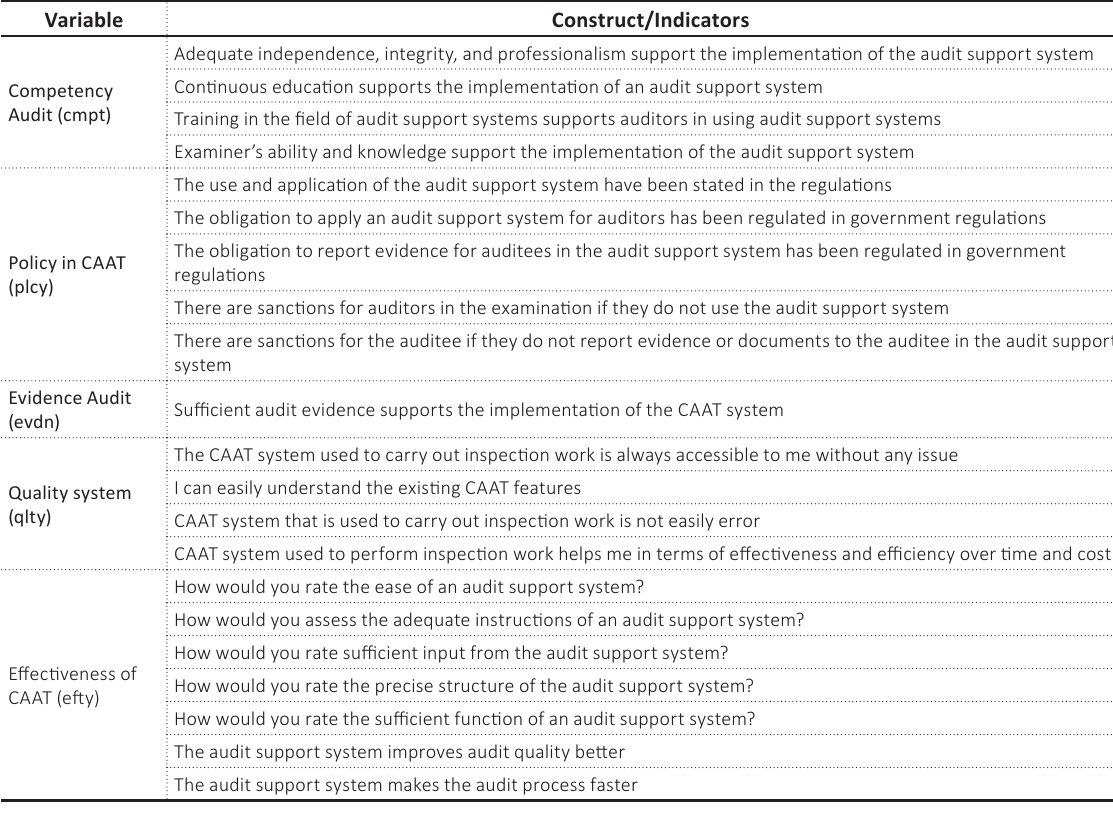
Table 1. Variable operation